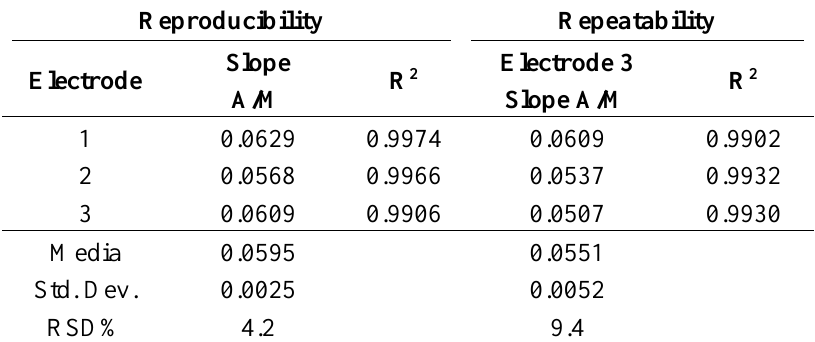
Table 5. Precision parameters obtained through ordinary least square (OLS) regression for W(VI) using one or different ALP modified SPCEs under optimum conditions on Table